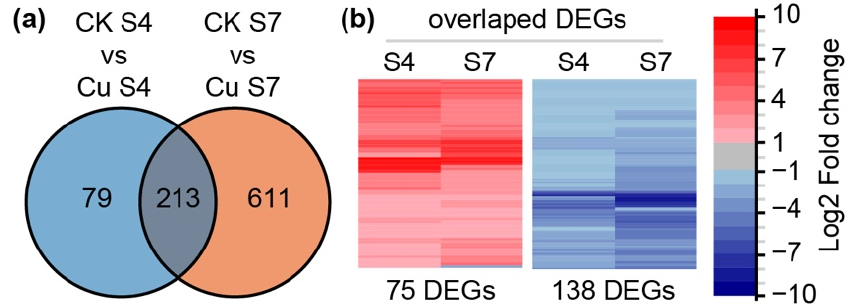
Figure 2. Differentially expressed genes (DEGs) in stage 4 and stage 7 petals after exposure to 40 µ M Cu. ( a ) Venn diagram showing the number of DEGs, fold change > 2 and FDR < 0.05, in stage 4 and stage 7 petals. ( b ) Heatmap showing the log2-fold change of DEGs shared by stage 4 and stage 7 petals.